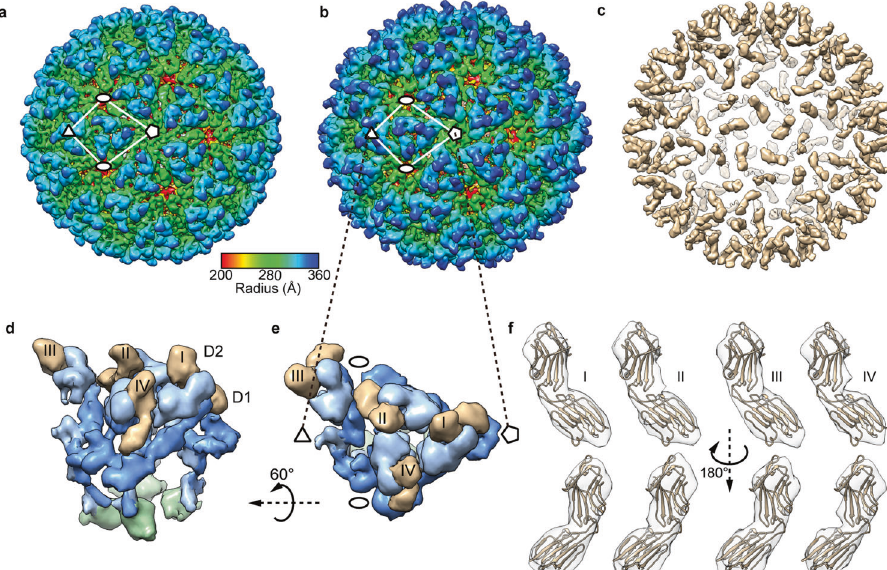
Fig. 3 Cryo-EM structures of OVM and the OVM-MXRA8 complex. a , b Radially colored cryo-EM maps of unbound OVM ( a ) and the OVM- MXRA8 complex ( b ). The locations of the icosahedral fi ve-, three- and two-fold axes are marked with pentagons, triangles, and ellipses, respectively. The bar shows the color scheme. c The difference map between unbound OVM and the OVM-MXRA8 complex. To highlight the major difference, small densities were hidden. d , e Enlarged view of an asymmetric unit of the OVM-MXRA8 complex. e is the enlarged view of the boxed asymmetric unit in ( b ). d is the asymmetry unit ( e ) rotated by 60°. The E1 protein is colored dark blue. The E2 protein is colored in light blue. The C protein is indicated in green. The density of MXRA8 is shown in tan. The numerals I – IV indicate the densities of four MXRA8 ectodomains. f The MXRA8 atomic model (PDB: 6JO8) was docked into the four MXRA8 densities, as viewed from two opposite